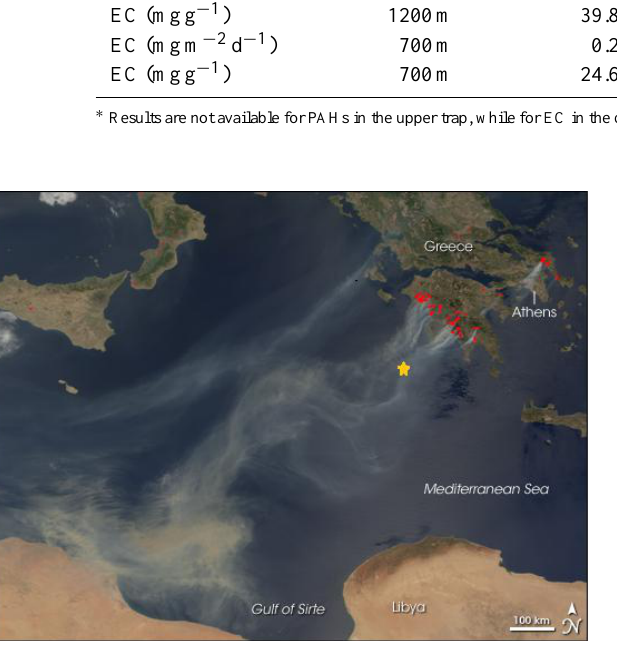
Fig. 7. Aqua-MODIS sensor satellite image above southern Figure 7. Aqua-MODIS sensor satellite image above southern Greece for the 26th of August 2007 Greece for the 26 August 2007 showing aerosol transport from showing aerosol transport from the burning Peloponnese over the sampling site and across the the burning Peloponnese over the sampling site and across the Mediterranean Sea. Adapted from NASA’s earth observatory (http://earthobservatory.nasa.gov/IOTD/ Mediterranean Sea. Adapted from NASA’s earth observatory (http: //earthobservatory.nasa.gov/IOTD/view.php?id=7996). The orange view.php?id=7996). The orange dot indicates the location of the mooring line, NESTOR 4.5. dot indicates the location of the mooring line, NESTOR 4.5.